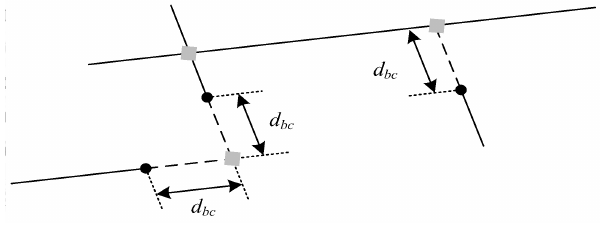
Figure 4. Building corners need to be detected and